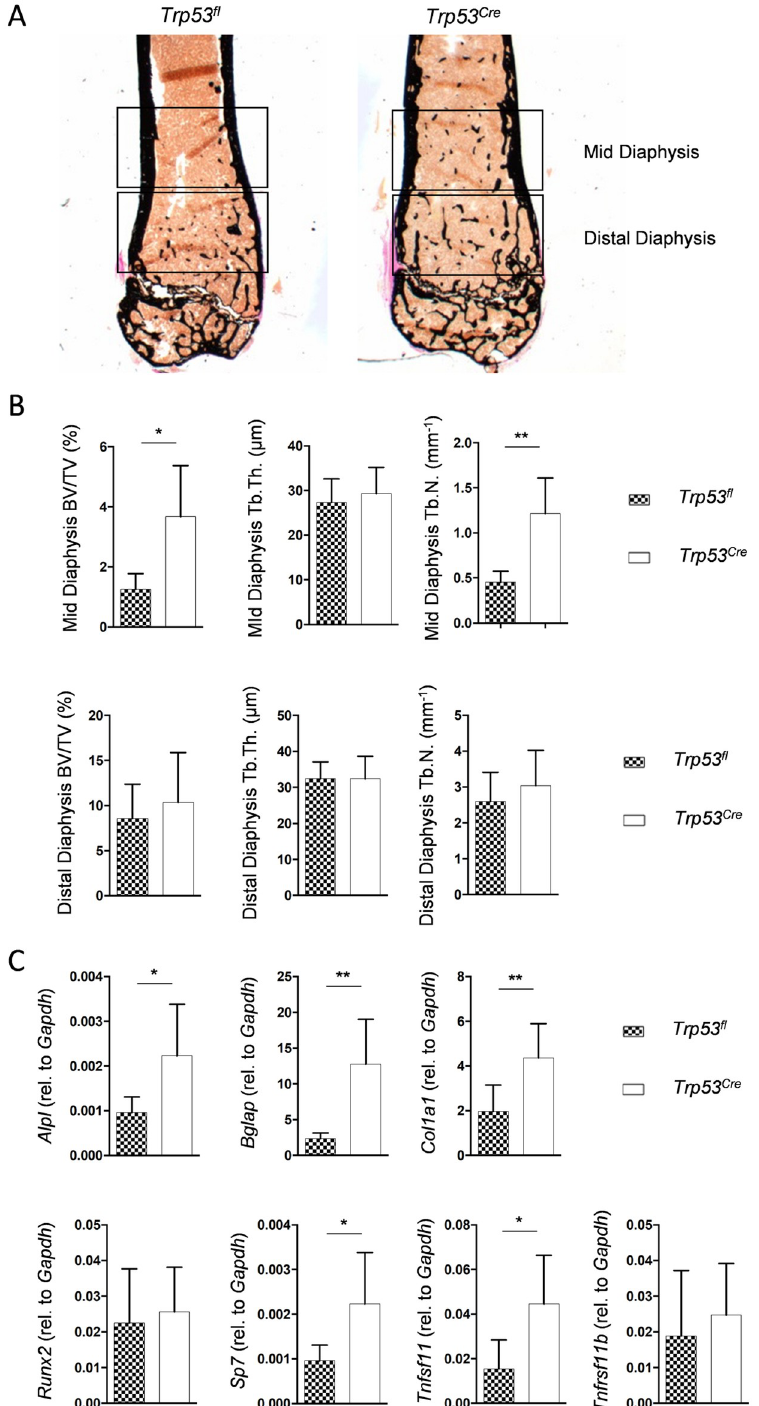
Fig 3. The Trp53 Cre phenotype is confirmed by femur histology and gene expression analysis. (A) Representative images of undecalcified femur sections from 6-month-old male mice with the indicated genotypes. Mineralized bone appears in black. The highlighted regions were separately analyzed. (B) Quantification of BV/TV, trabecular thickness (Tb.Th.) and trabecular number (Tb.N.) in the mid diaphysis (top) or the distal diaphysis (bottom) in 6-month-old male mice with the indicated genotypes. (C) qRT-PCR analysis for expression of the indicated genes in the femur, relative to Gapdh . Data represent mean ± SD (n � 6). Asterisks indicate statistically significant differences ( � p < 0.05, �� p <